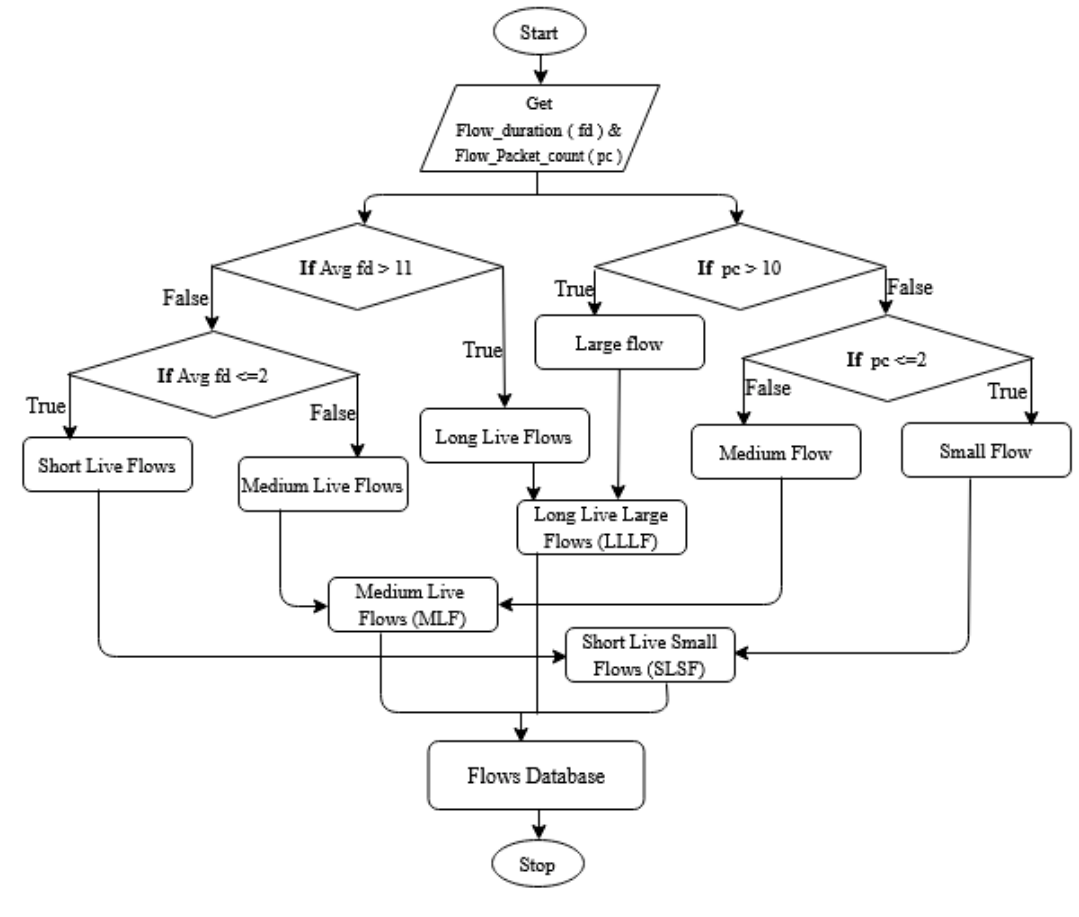
Figure 5. Flow Figure 5: Flows categories